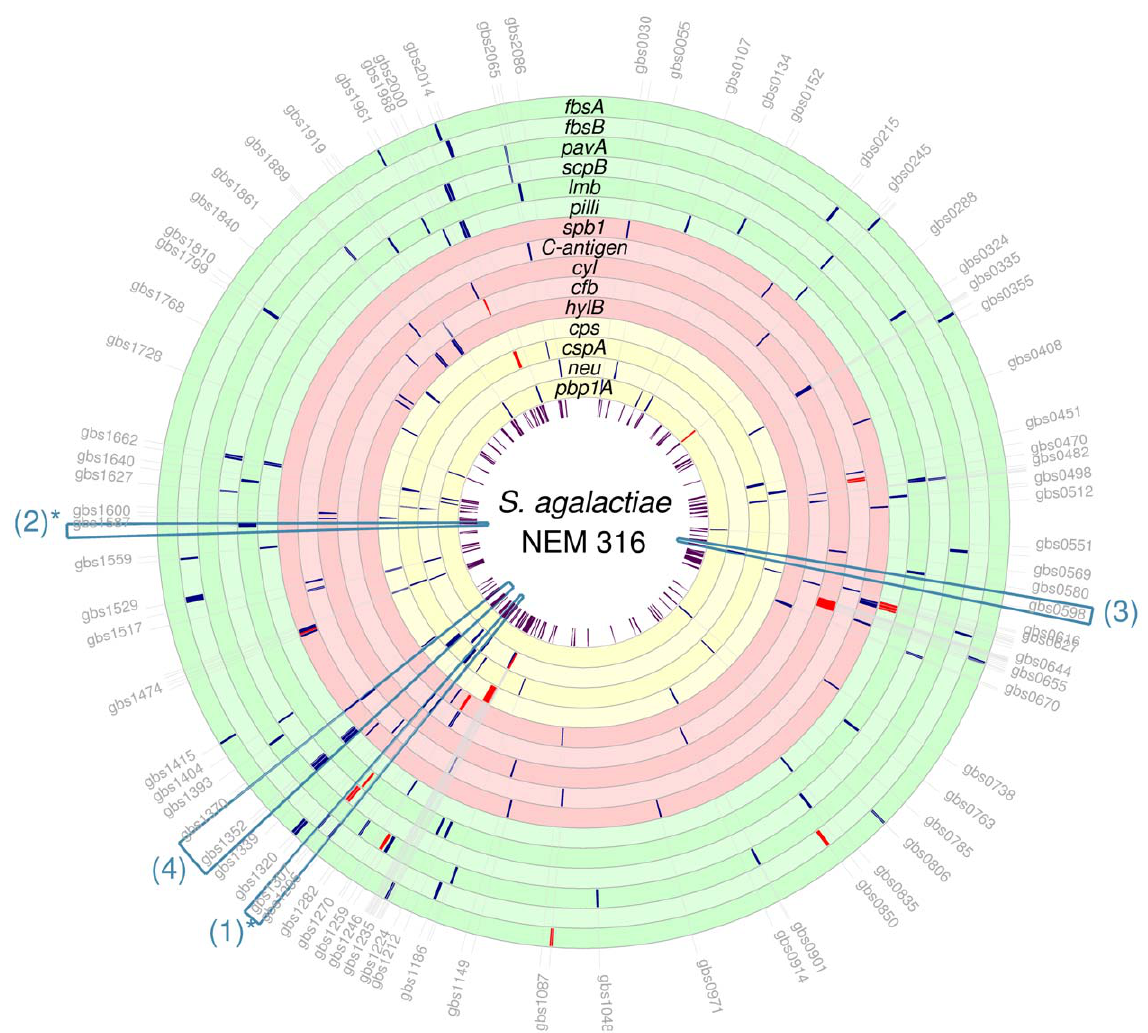
Figure 5. Positions of the training set (in red) and top-10 genes (in blue) in each of the 15 virulence gene categories in S.agalactiae NEM316 genome (serotype III). The highly-ranked genes is shown to be scattered across the entire GBS genome and not aggregated in close physical proximity. Physical linkages between the known and the prioritized genes are therefore unlikely. This illustration demonstrated the novelty of the PP approach for virulence gene discovery compared with the traditional paradigm of physical linkage and gene clusters. The blue boxes refer to the known genomic islands and are discussed in the results section. (*) Predicted by homology to other reference genomes, as islands (1) and (2) were not listed in PAI-DB or IslandViewer for